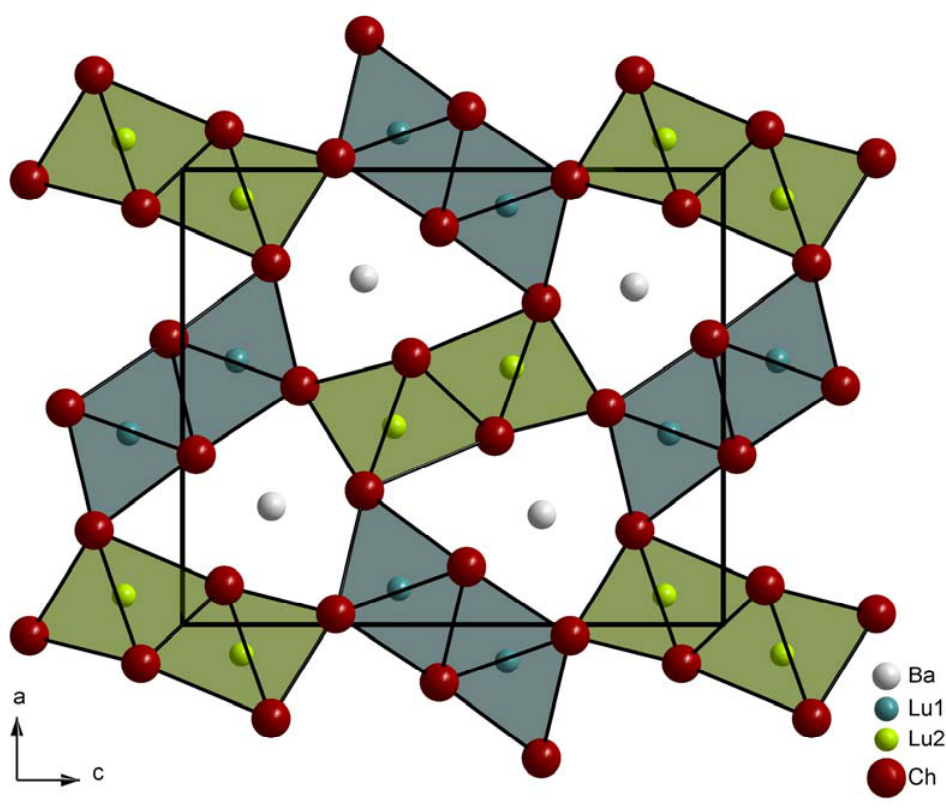
Figure 3. View of the crystal structure of the BaLu the 3 {[Lu Ch ] 2– } framework with channels is filled up by barium 2 4 